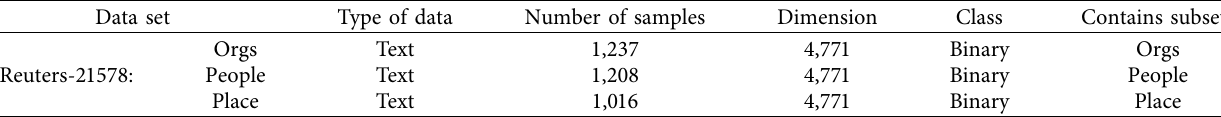
Table 2: Description of reuters-21578 data